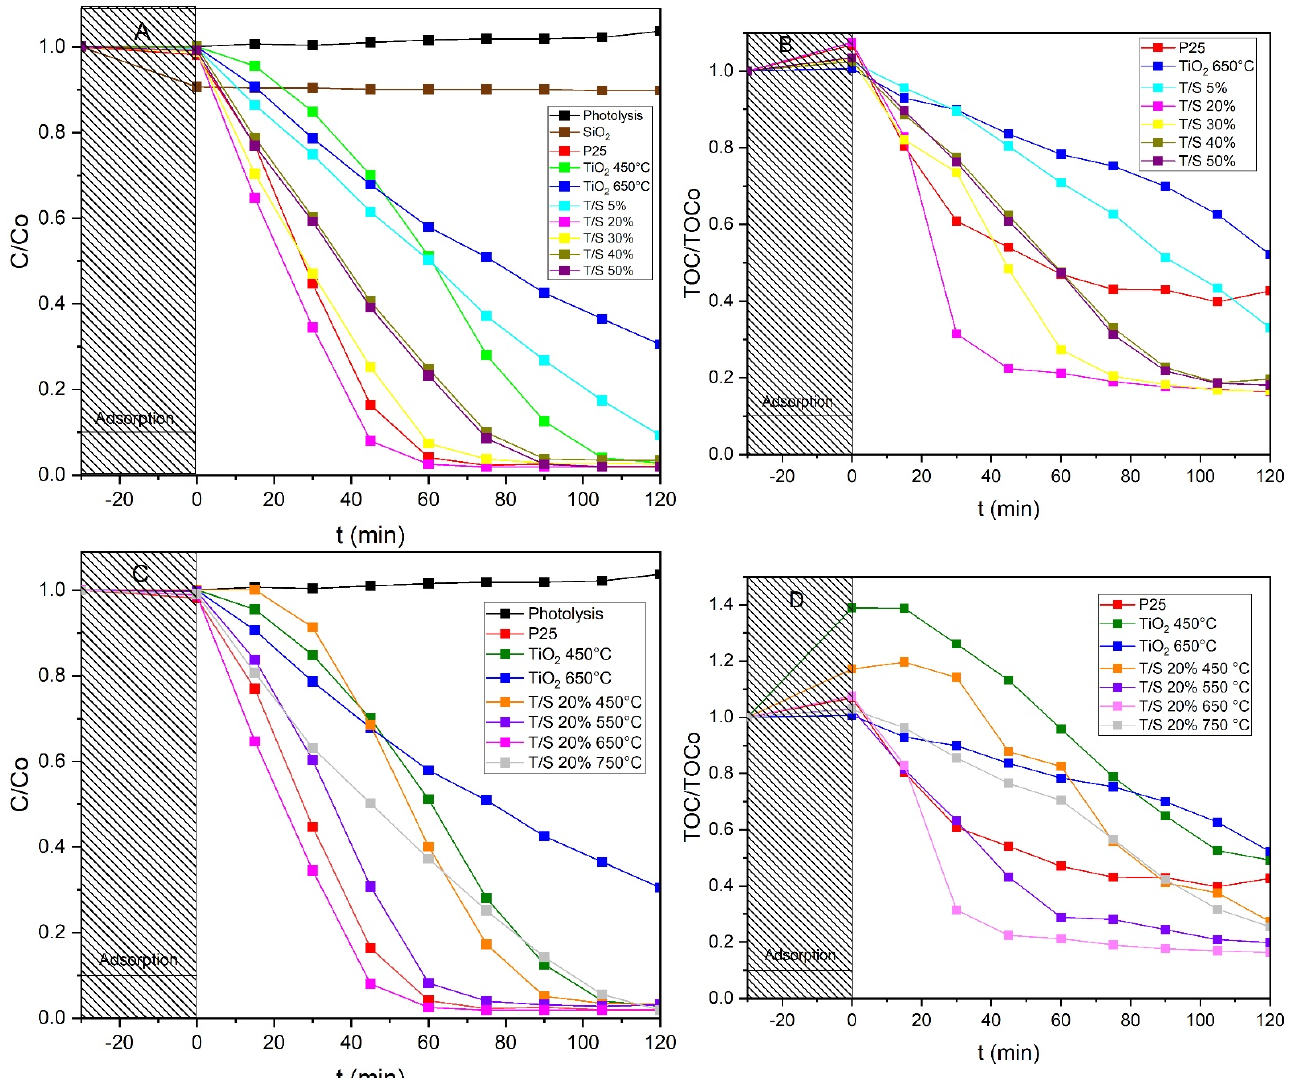
Figure 8. Photocatalytic degradation mineralization of SDCF in the presence of catalysts with different SiO 2 content compared to pure TiO 2 and commercial P25 ( A , B ) and in the presence of TS 20%–T catalyst calcined at different temperatures compared to pure TiO 2 and commercial P25 ( C , D